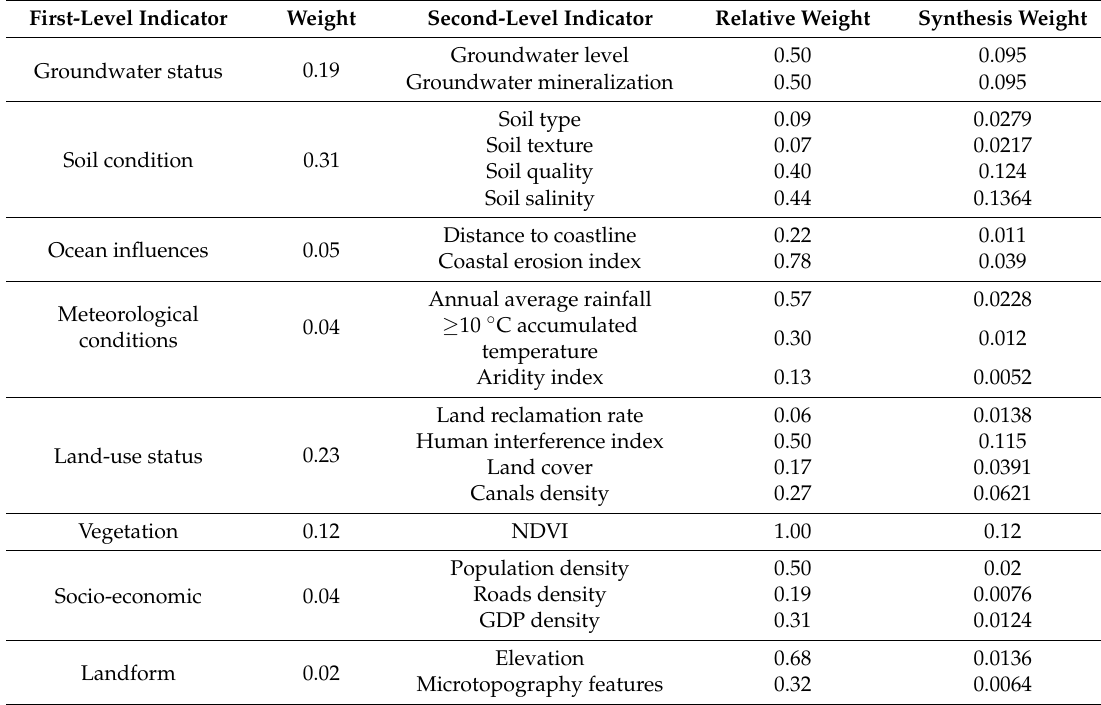
Table 6. Weights of all indicators for EV.